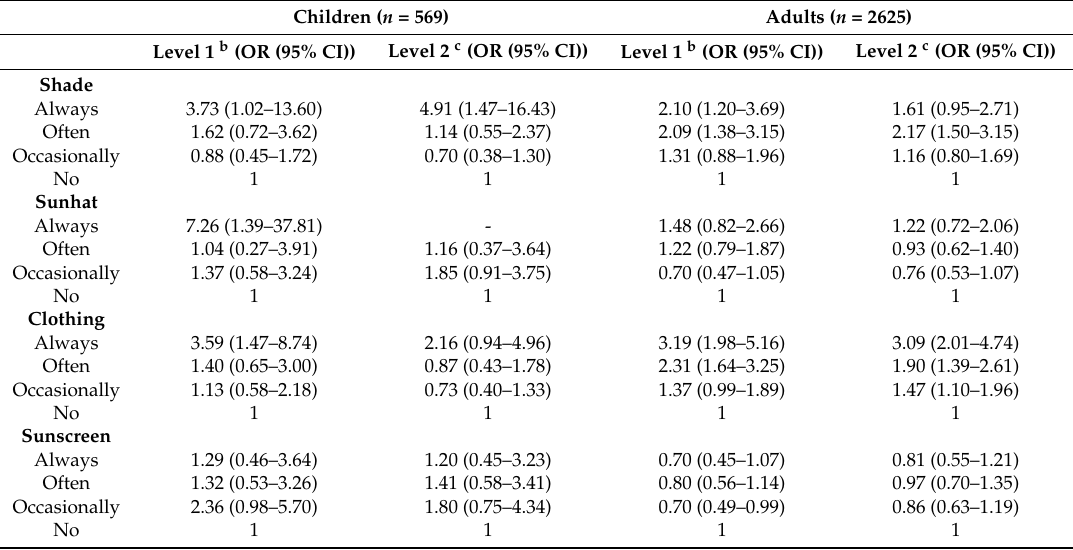
Table 3. Adherence to sun exposure guidelines in relation to odds ratio (OR) of having low vitamin D status a